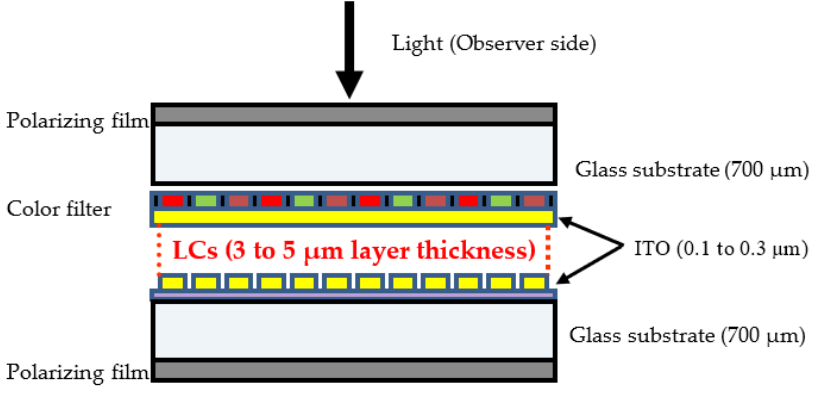
Figure 2. Schematic localization of LCs in the LCD panels .